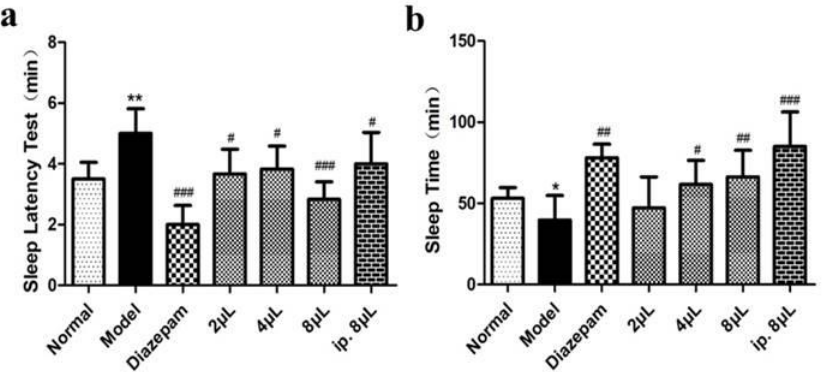
Figure 1. Effects on sleep of AEO inhalation. ( a ) Sleep Latency Test, ( b ) Sleep Time. All values are expressed as the means ± SD ( n = 8). * p < 0.05, ** p < 0.01 vs. normal group; # p < 0.05, ## p < 0.01, ### p < 0.001 vs. model group.